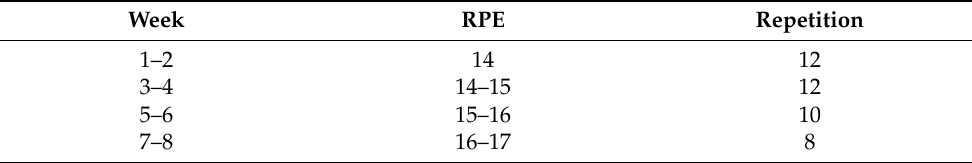
Table 2. RPE and repetitions. Abbreviations. RPE, Borg Rating of Perceived Exertion. Week